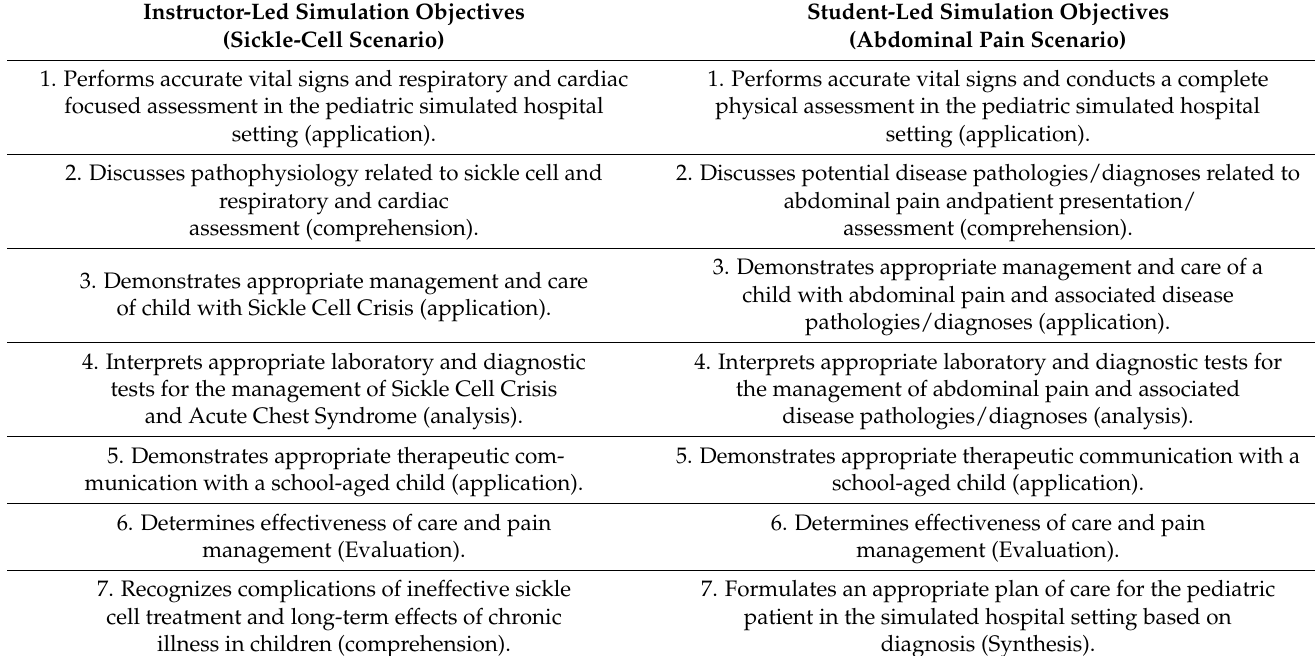
Table 1. Simulation